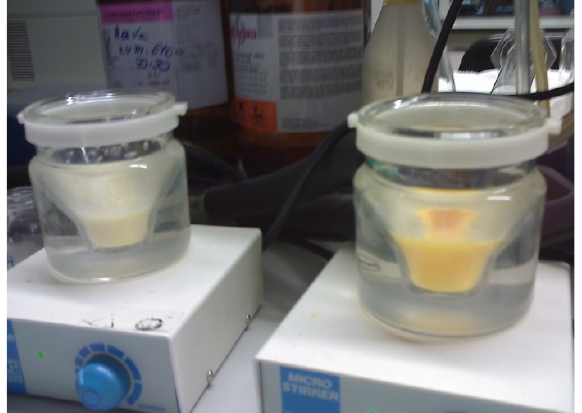
Figure 1. Photographs of the reaction mixtures obtained in olive oil emulsions after reacting 16-ArN 2+ with α -TOC (left) and δ -TOC (right). The yellowish color is a consequence of the formation of an azo dye between 16-ArN 2+ and δ -TOC.